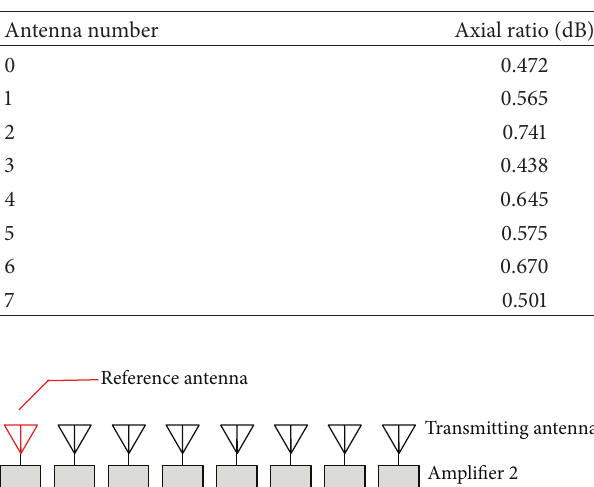
Table 2: Computed beam specifications.